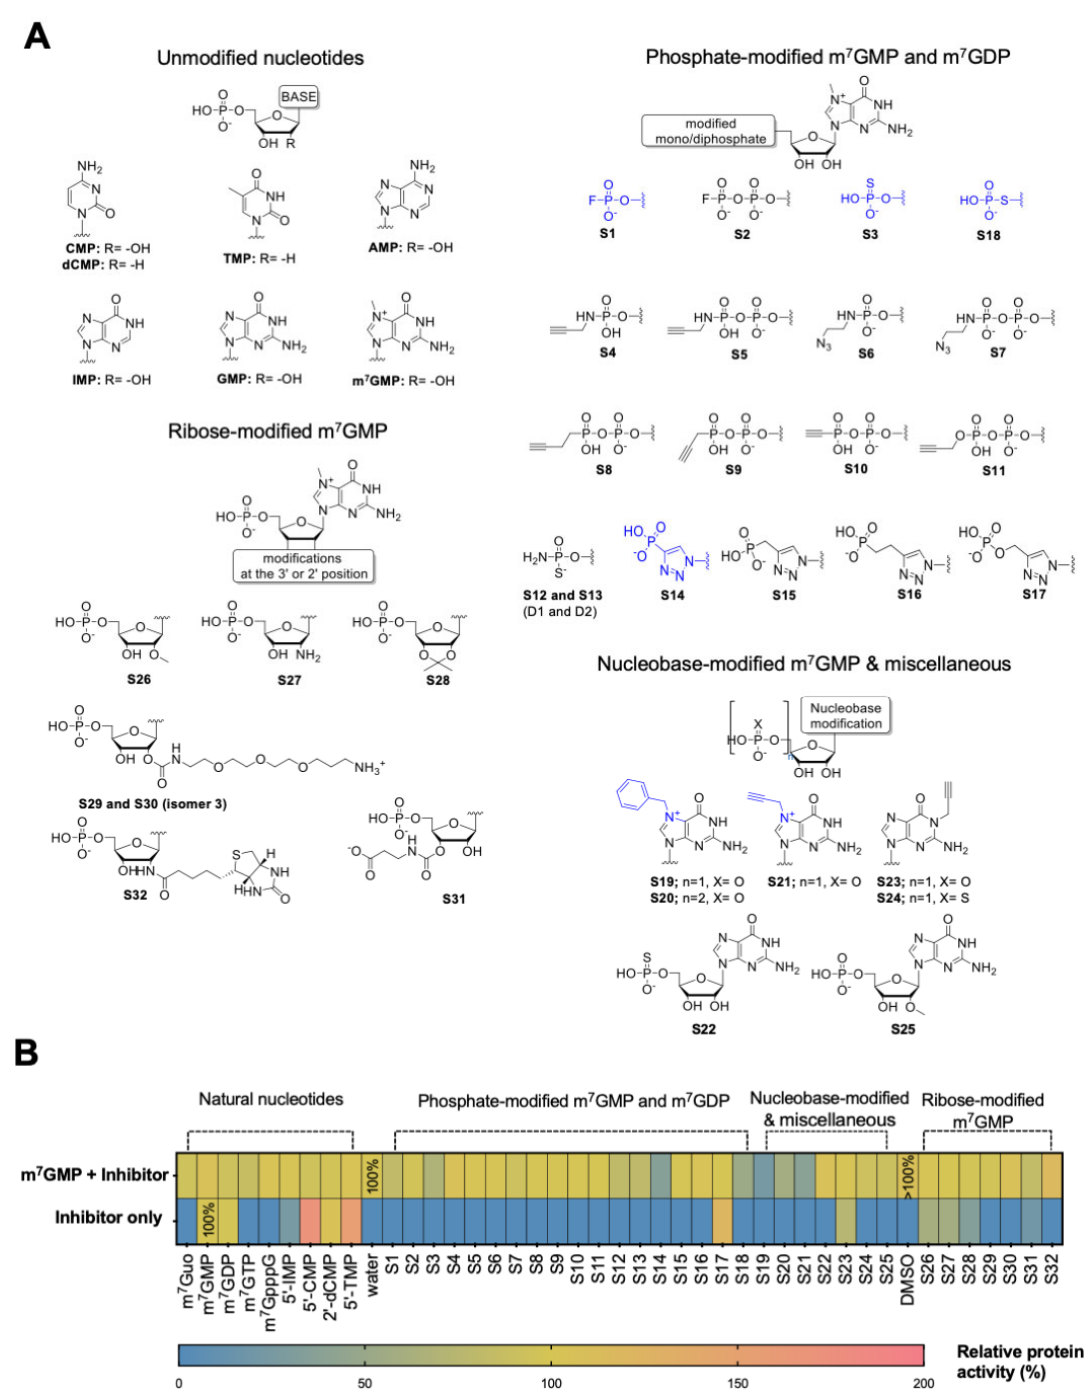
Figure 1. Evaluation of the first-generation library of compounds as cN-IIIB substrates and inhibitors. ( A ) Chemical structures of all four groups of nucleotides from the library. ( B ) Heat map of inhibitory potency and hydrolysis of 41 compounds of library I. Inhibitory potency was measured as the % of substrate dephosphorylation, m 7 GMP, by cN-IIIB enzyme in the presence of the inhibitor. Depending on the solubility of compounds, their stock solution was dissolved in water or DMSO, and the graph presents the control reaction for both solvents. The data represent mean values ± SD from duplicate.